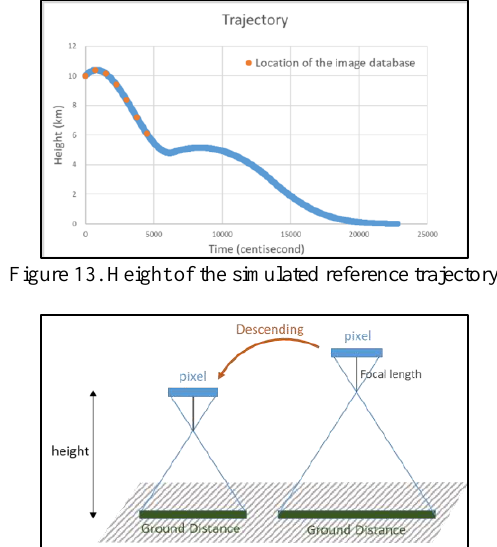
Figure 14. Relationship between a pixel and the ground during